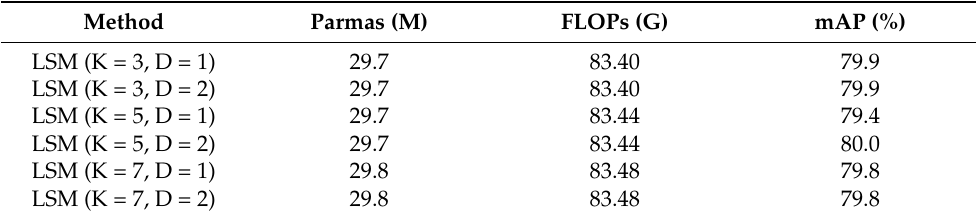
Table 6. Ablation study of the proposed lightweight spatial module